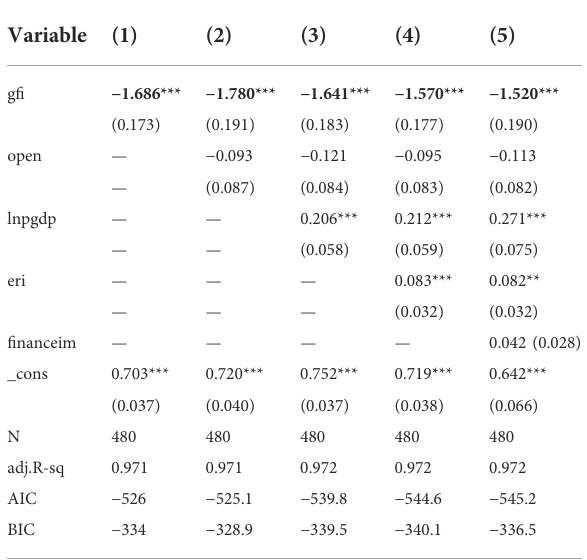
TABLE 7 OLS panel regression